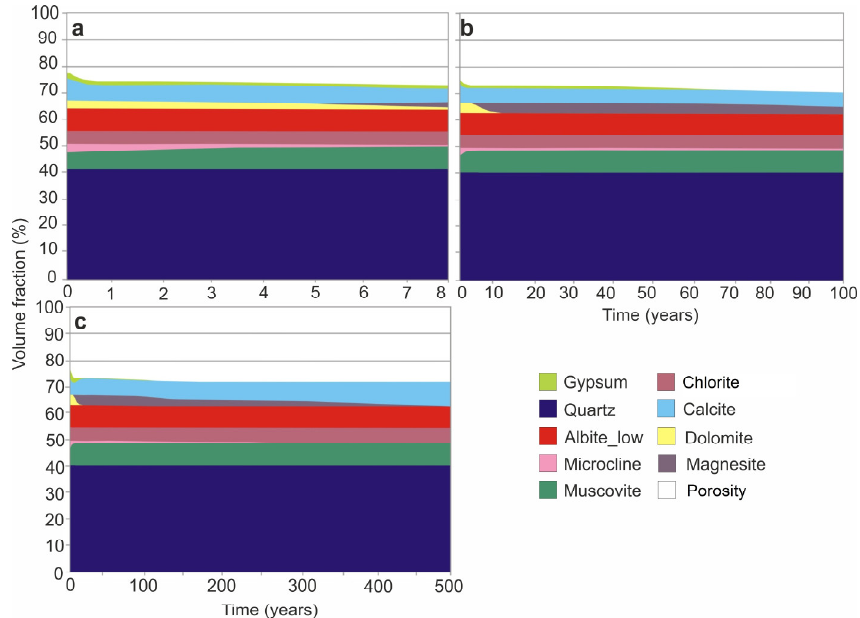
Figure 5. Mineralogical changes in the Br-52 rock sample over 8 years of injection ( a ) and after 100 years ( b ) and 500 years ( c ) from the completion of injection at a distance of 20 m from the injection borehole.